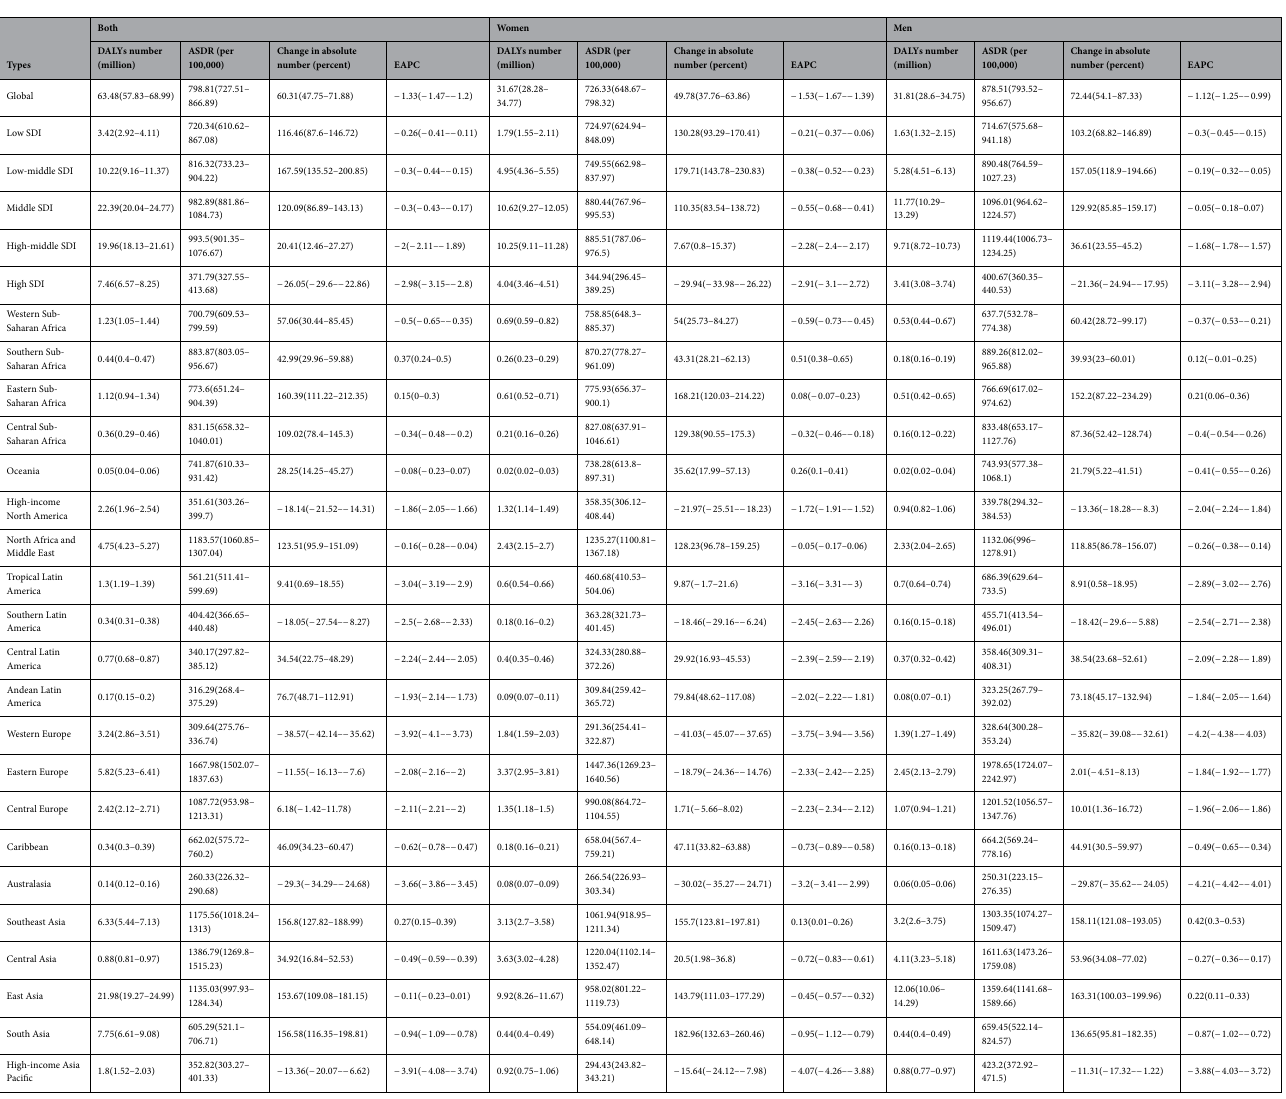
Table 1. The sex-specific DALYs number and age-standardized DALYs rate due to ischemic stroke in 2019, and its temporal trends from 1990 to 2019. Abbreviations: DALYs, disability-adjusted life years; ASDR, age- standardized DALYs rate; SDI, socio-demographic index; EAPC, estimated annual percentage